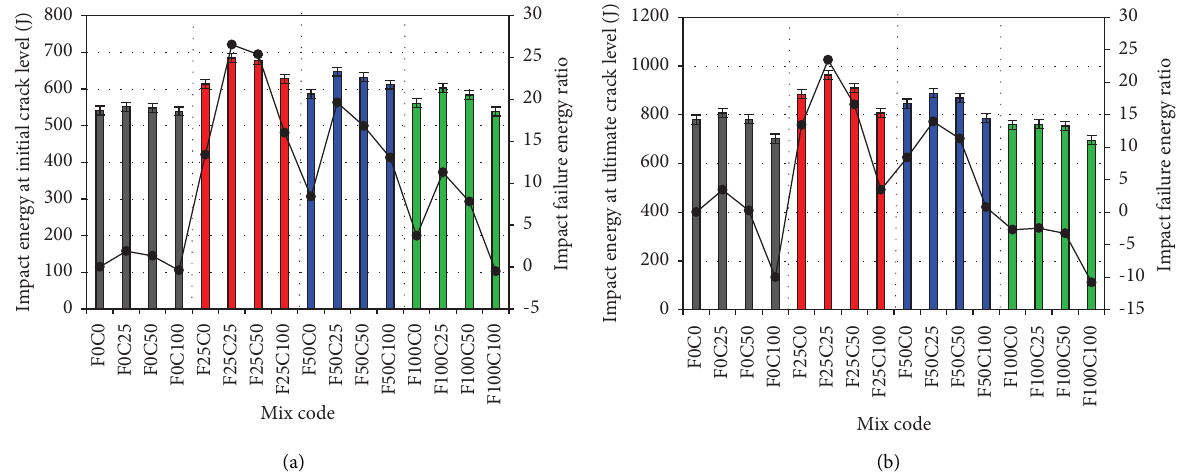
Figure 10: Te impact energy (a) at initial crack level and (b) at ultimate crack level.